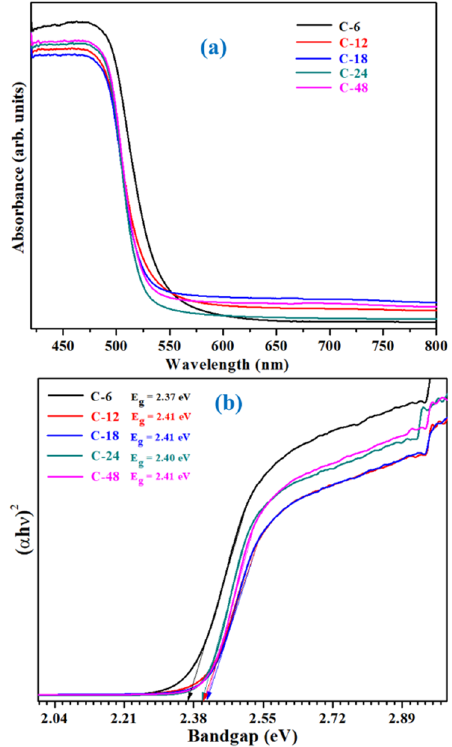
Figure 7. UV-vis diffuse reflectance absorbance spectra ( a ) and ( b ) optical bandgap measurements of CdS nanorods prepared at different reaction times.